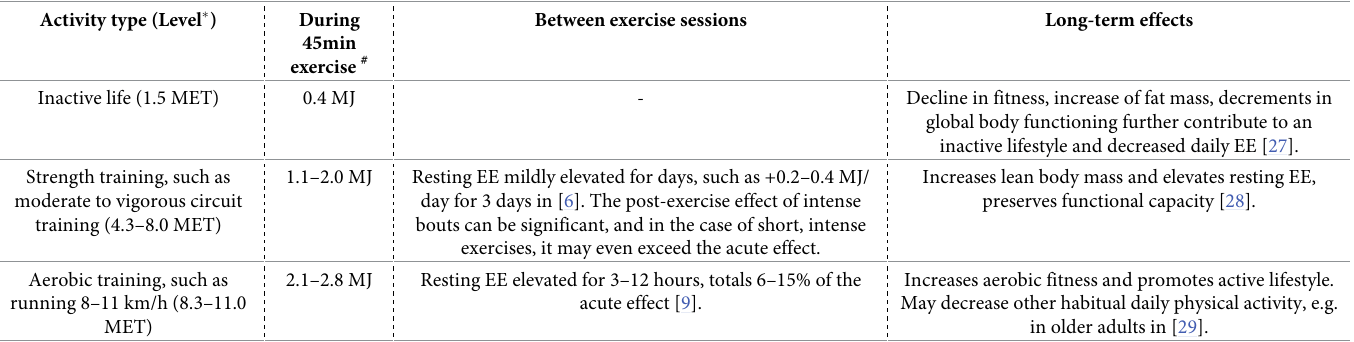
Table 1. Contribution of sedentary life, aerobic and strength training to daily energy expenditure during exercise, between exercise sessions, and after long-term participation in training. Activity type (Level �